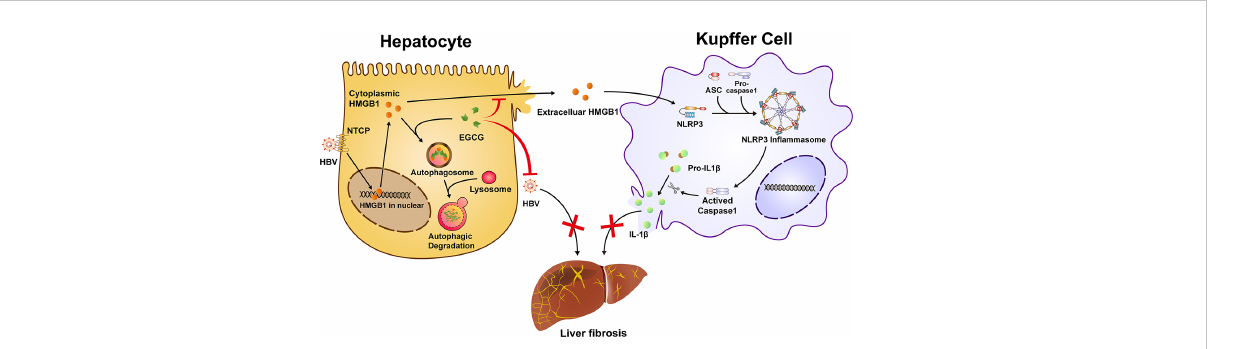
FIGURE 7 Schematic illustration of EGCG protects against HBV-induced liver injury and fi brosis via autophagic degradation of hepatic HMGB1. HBV triggers the nucleus-cytoplasmic translocation of HMGB1 and its following secretion from hepatocytes. Extracellular HMGB1 further participates in the activation of macrophage in fl ammasome, a critical aggravator of liver fi brosis. EGCG induces the autophagic degradation of cytoplasmic HMGB1 in hepatocytes and reduce its extracellular secretion, thus inhibiting NLRP3 in fl ammasome activation in Kupffer cells. Together, besides its inhibition of HBV replication, EGCG treatment ameliorates HBV-induced liver injury and fi brosis via inhibiting extracellular HMGB1-mediated macrophage in fl ammasome